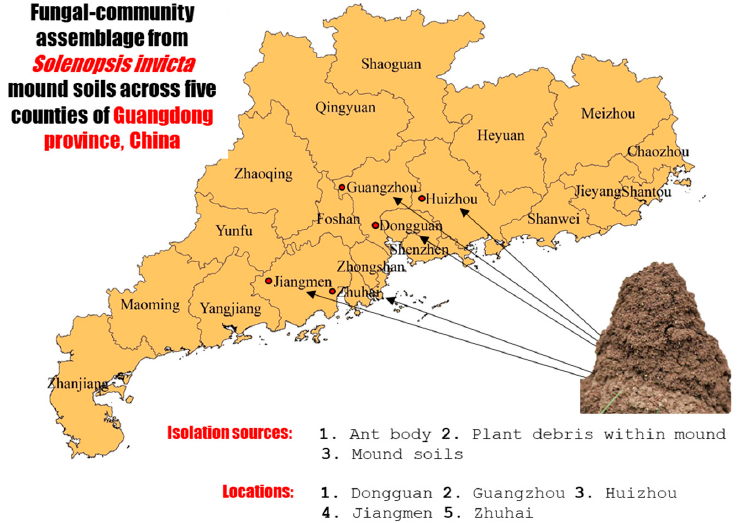
Figure 1. Diagrammatical representation of experimental layout, detailing the various sources of isolation and sampling locations for baseline analysis of fungal associates of RIFA.